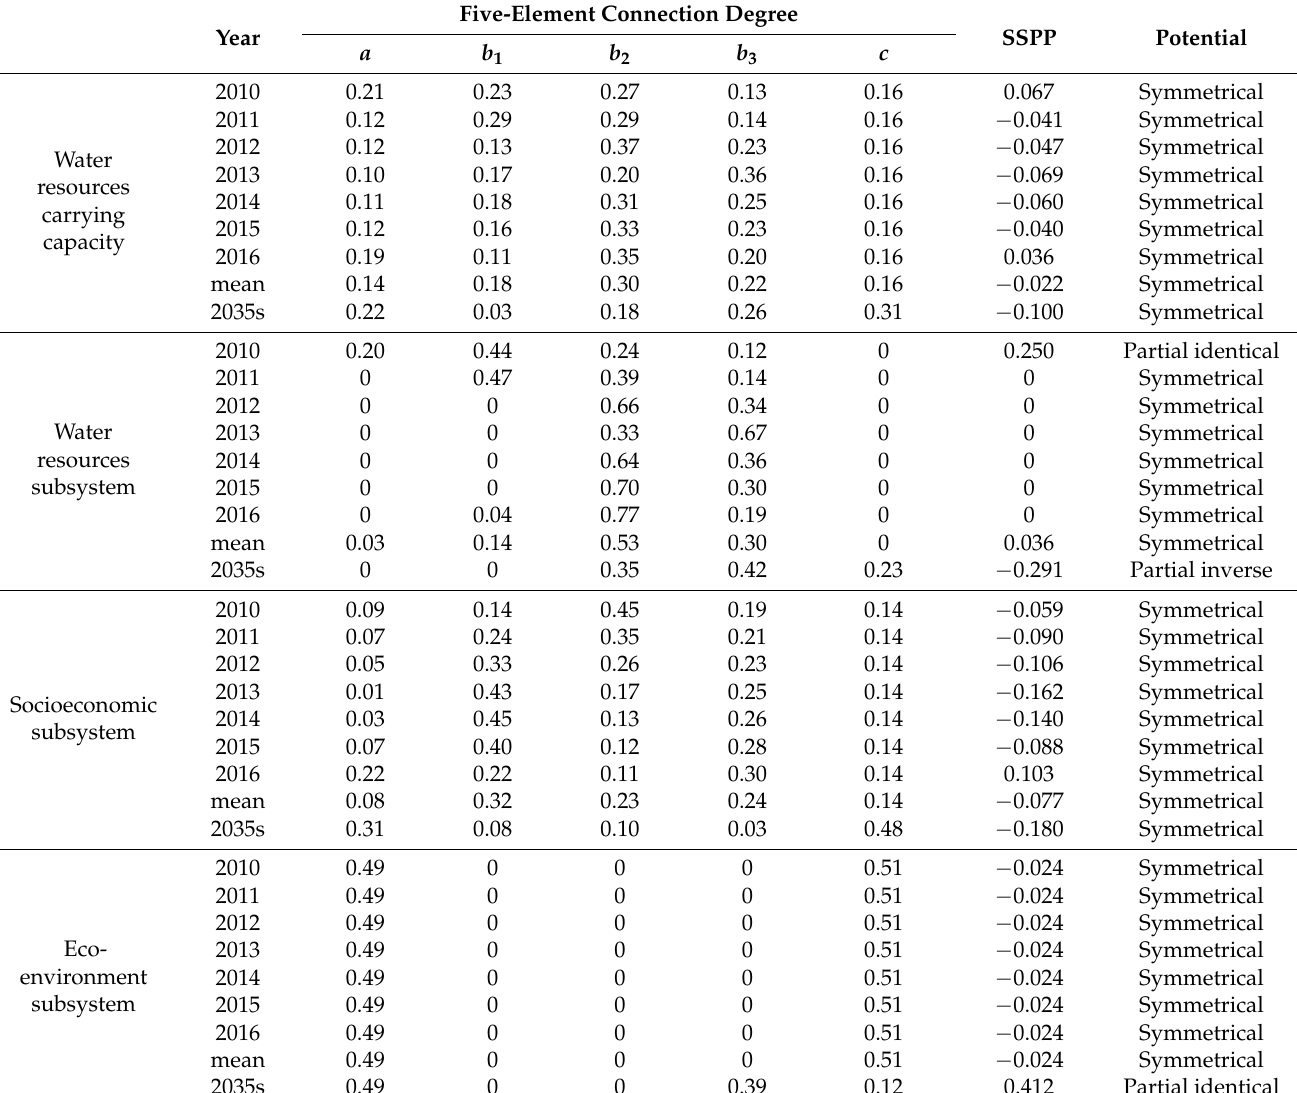
Figure 5. The five-element connection degree of the WRCC. Table 5. WRCC connection and subtraction set pair